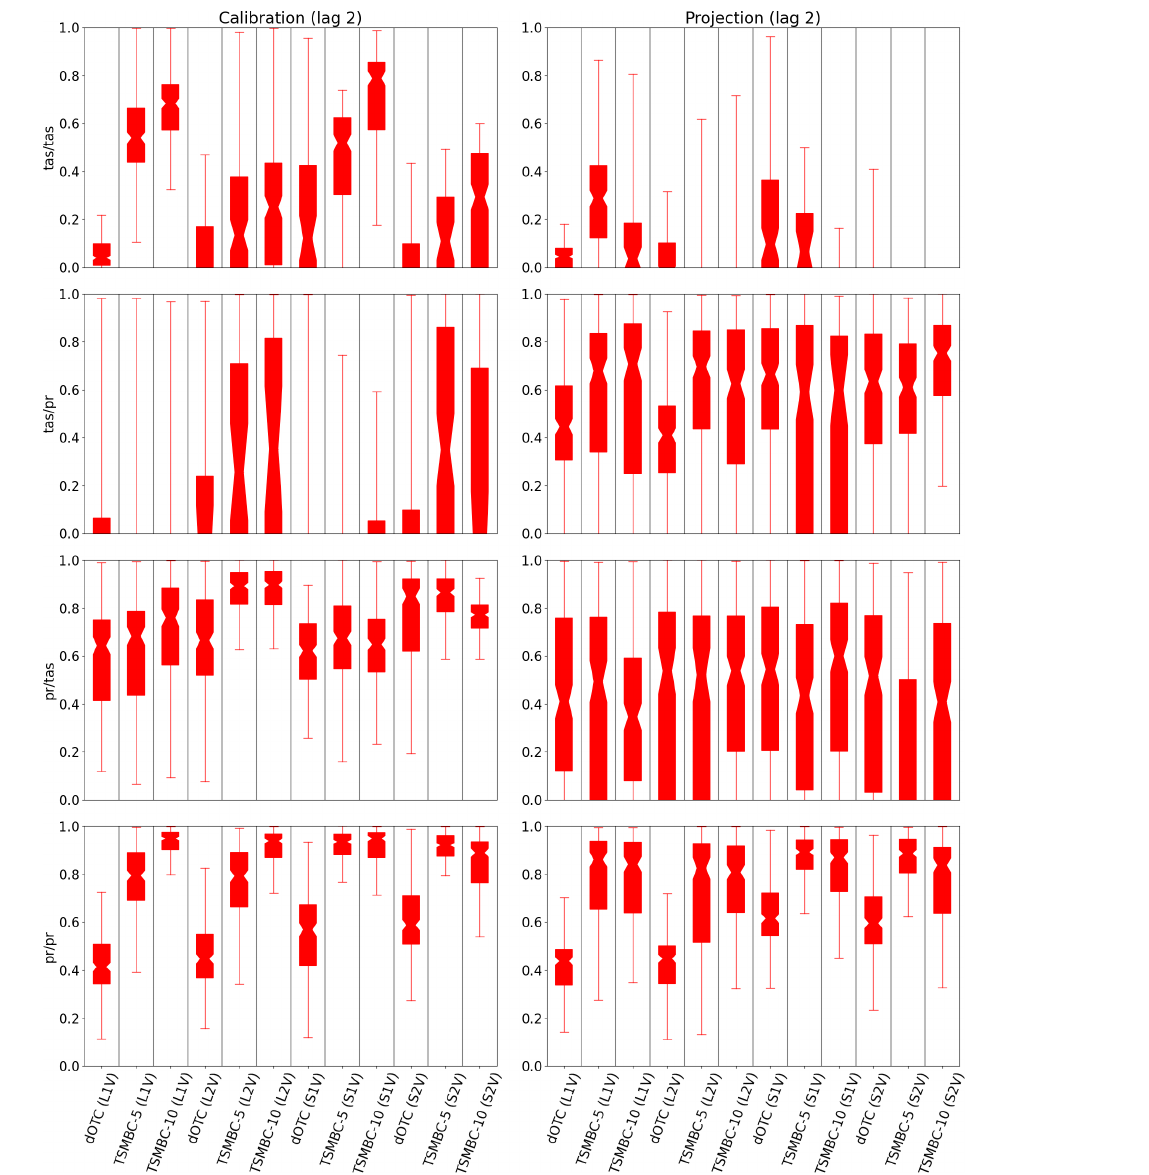
) in calibration (first column) and projection (second column) 2